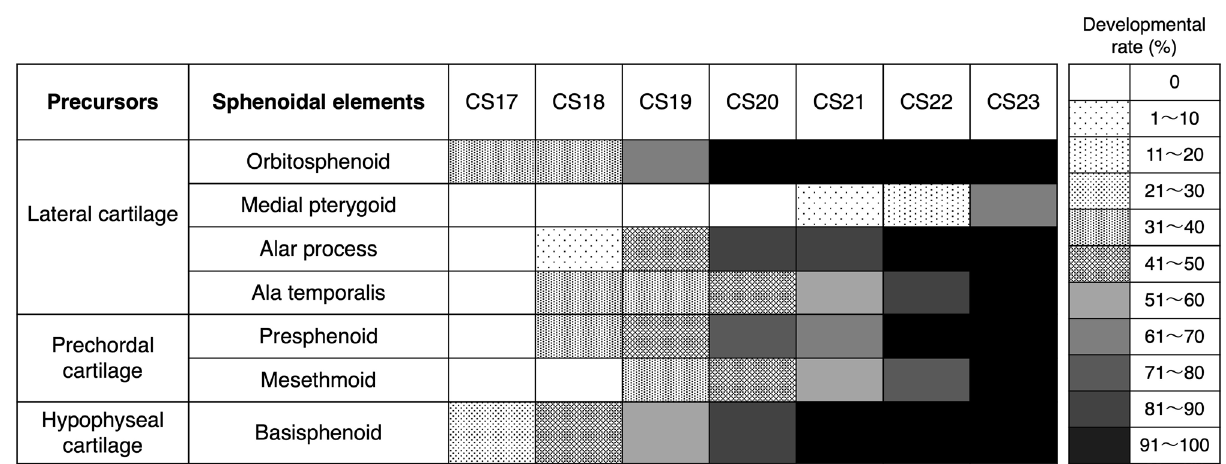
Figure 2. Precise development of each element of the sphenoid. In histological sections, elements that were still cellular condensation were counted as 0.5, and those that produced cartilaginous matrix were counted as 1. Then, the value in each stage was summed up and divided by the number of all specimens, and the developmental rate of each element was calculated. A specific color or pattern was assigned to each 10% of the developmental